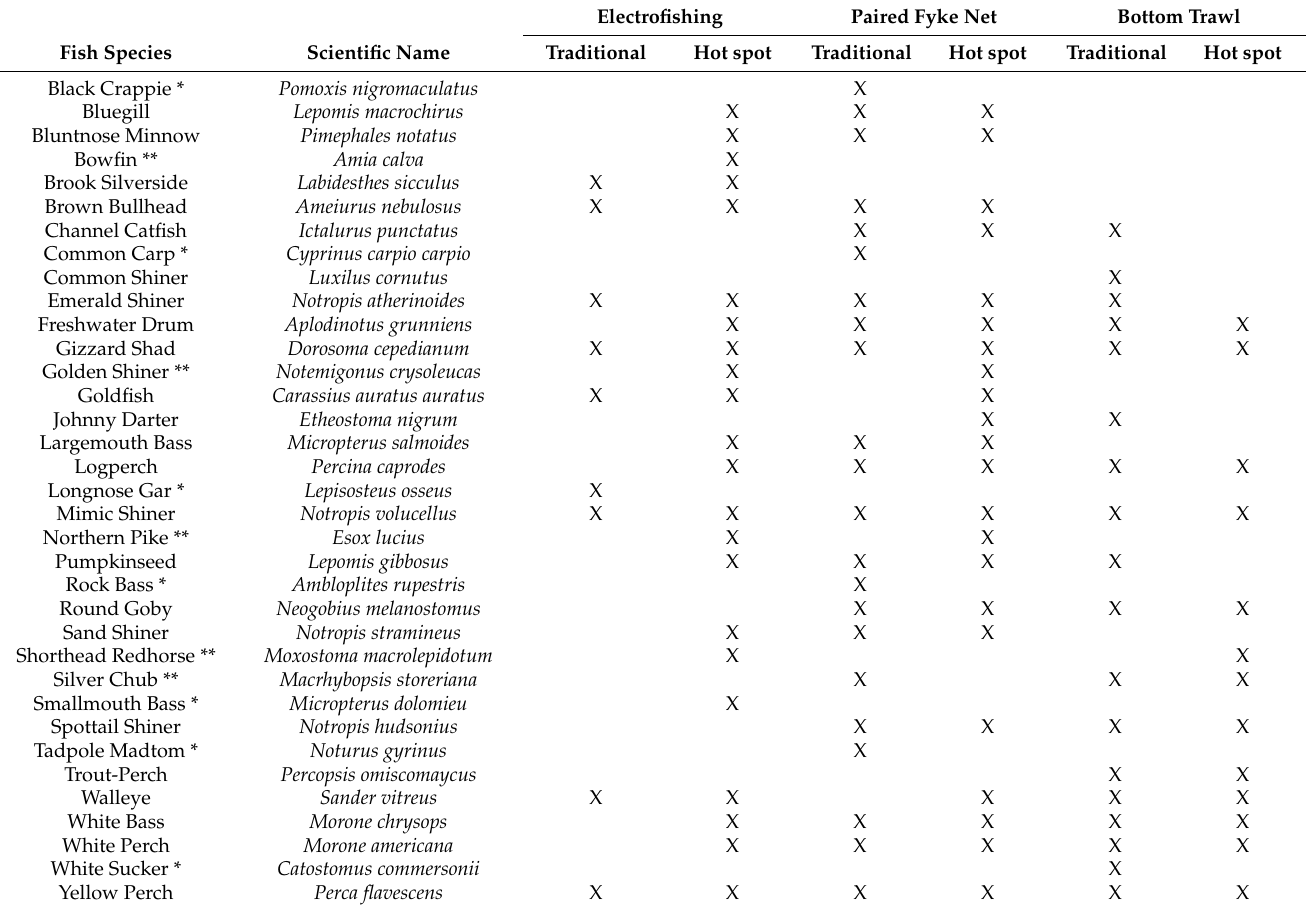
Table 2. Fish species captured (indicated by an “X”) in Maumee Bay during 2017 by gear type and site type (traditional n = 15, hot spot n =